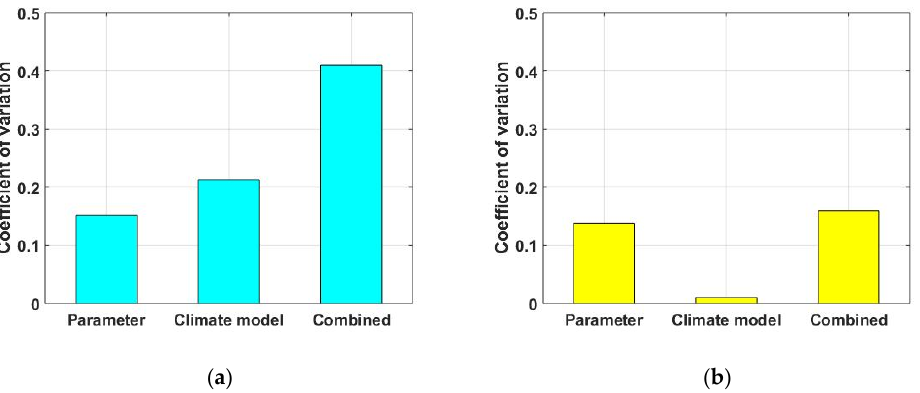
Figure 7. Coefficient of variance in rainfall quantile for return level of 50 years from ( a ) the stationary model; ( b ) the non- stationary model 𝑛 2 at the Cheonan site. The ensemble was obtained from the posterior distribution by the Metropolis– Hastings (MH) algorithm. “Parameter” describes the uncertainty that arises when fitting the observed AMR to a stationary or non-stationary generalized extreme value (GEV) distribution. “Climate model” represents the uncertainty arising from various combinations of climate models under the Representative Concentration Pathway (RCP) 4.5 climate change sce- nario. “Combined” represents the combined uncertainty arising from parameter estimation and climate model combina-